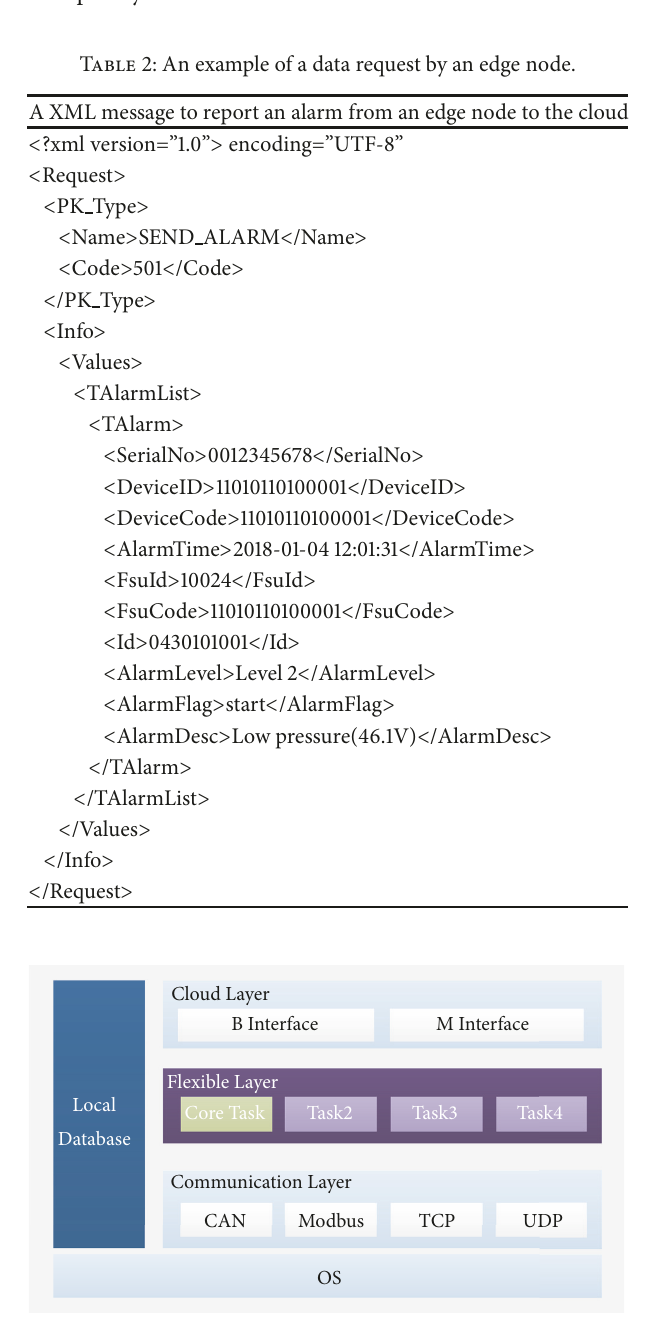
Modbus/RTU), but can be trimmed or changed by the cloud server according to the configuration file.